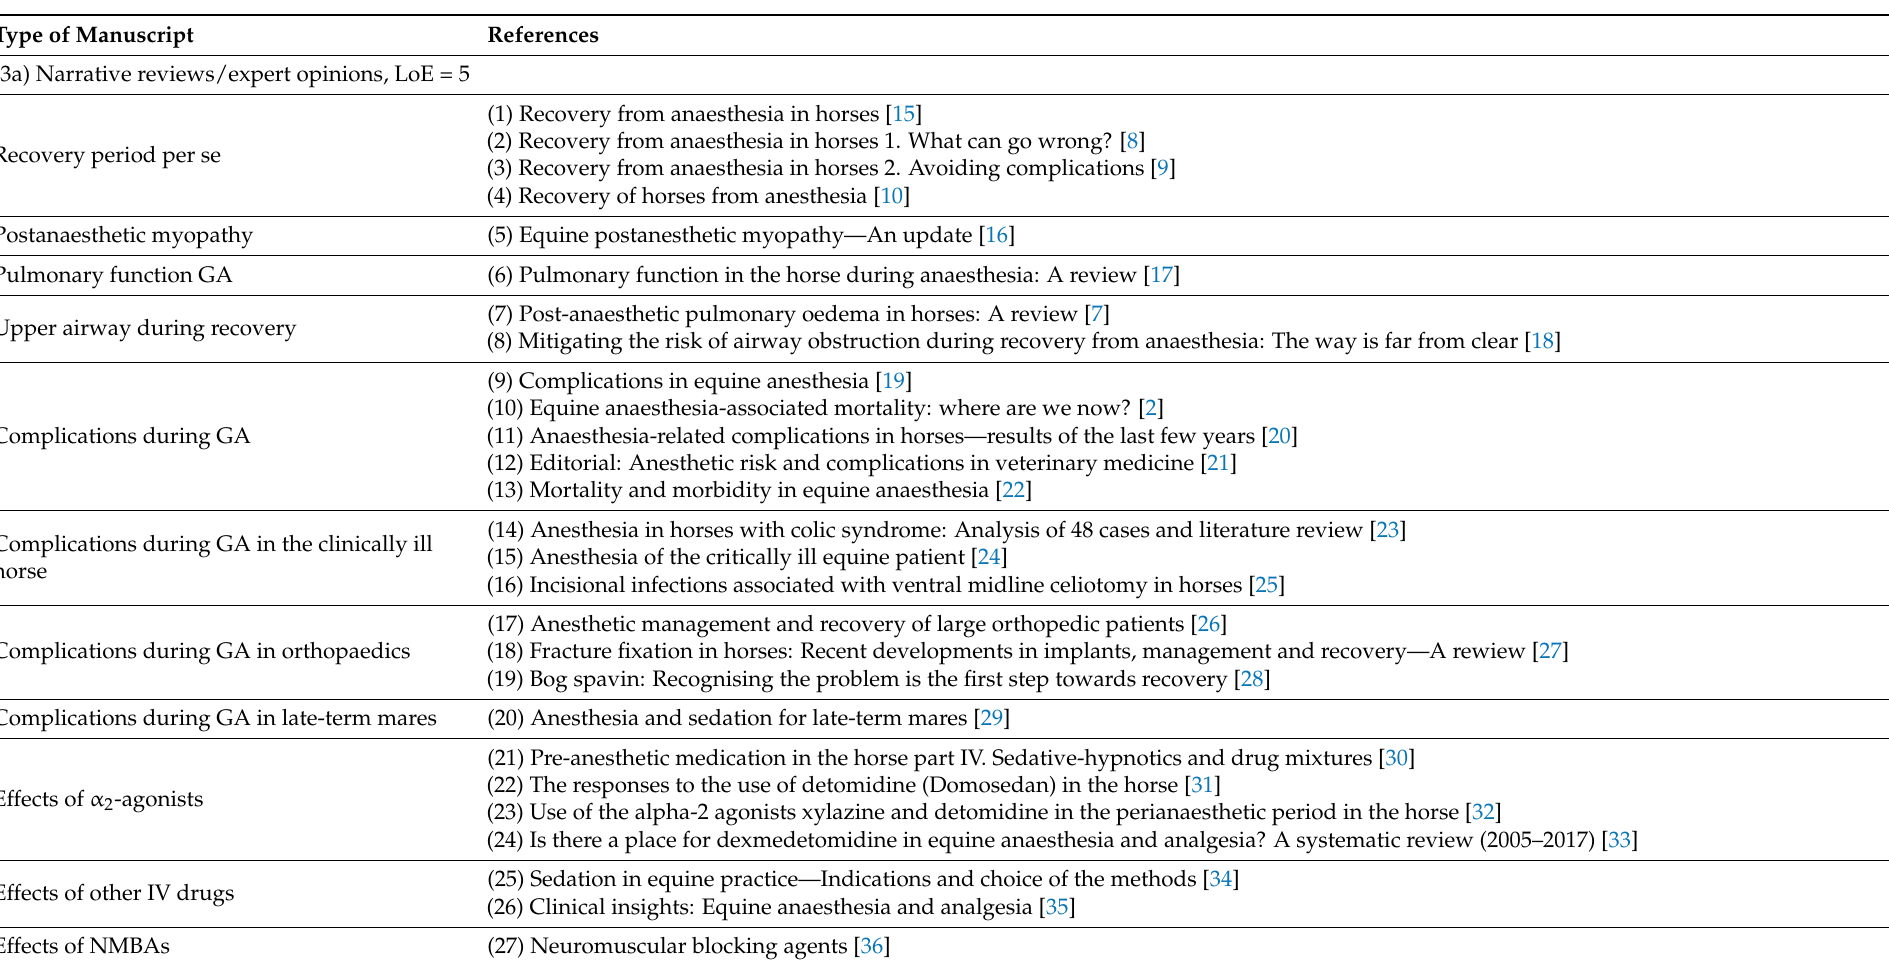
Table 3. Total of: (3a) “ narrative reviews/expert opinions ”, (3b) “ retrospective outcome studies ” and (3c) “ surveys ” including information regarding the recovery